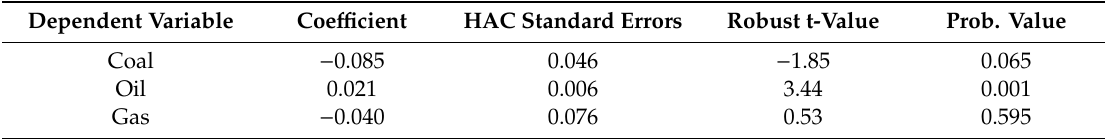
Table 25. Dummy variables (LDV) regression results of stock returns for coal, oil and gas. Dependent